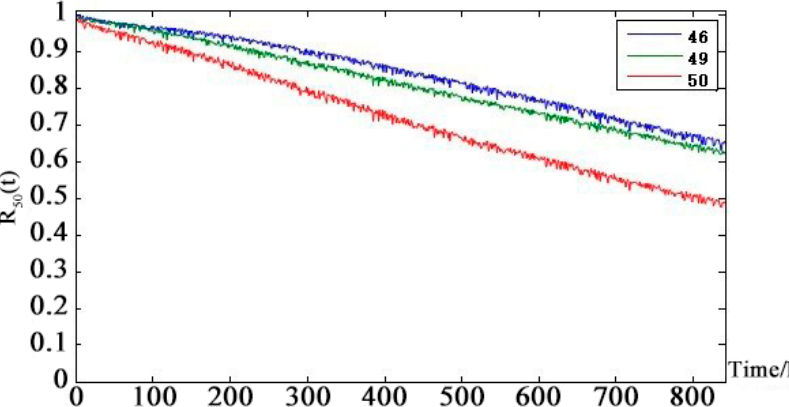
Figure 12. Health state probability prediction curve of Solar-powered UAV data-link intermediate node future 840 h (Continued).